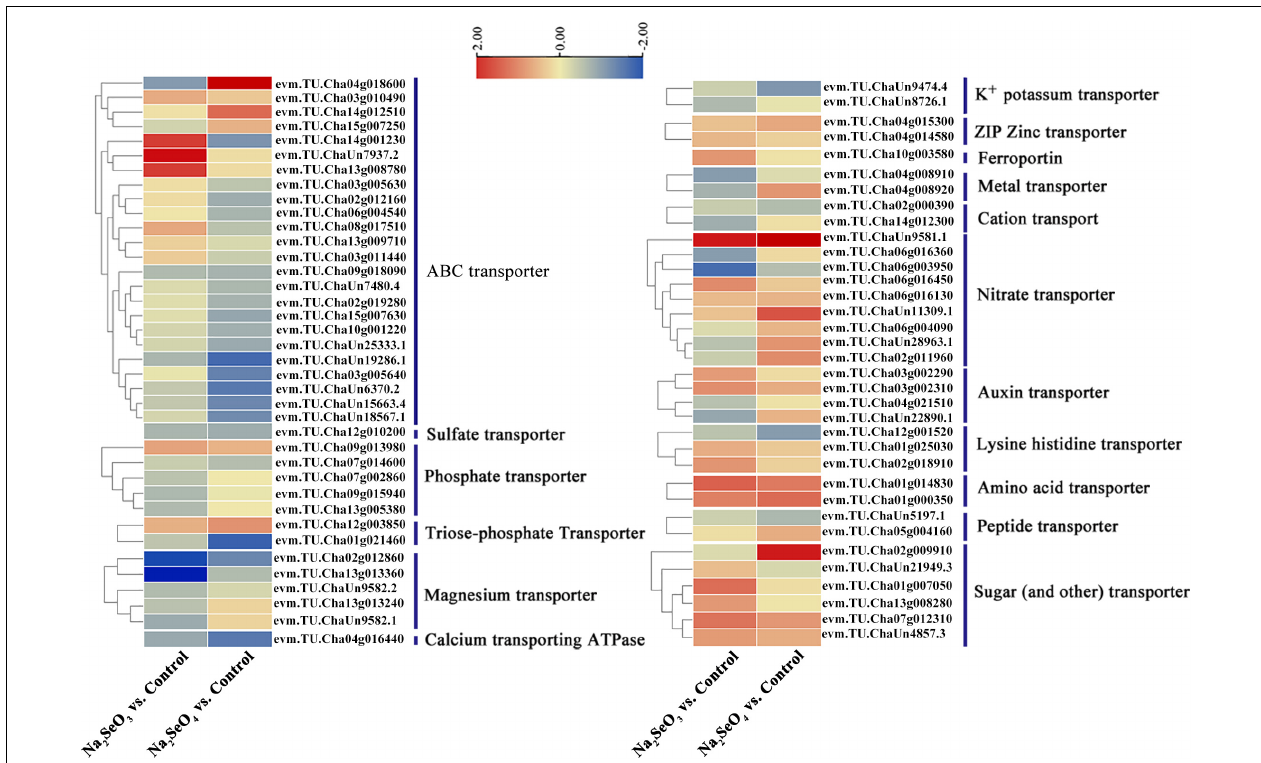
FIGURE 4 | Heatmap of putative Se transporters identified from DEGs. Different colors indicate different gene expression levels based on log 2 FoldChange. The same